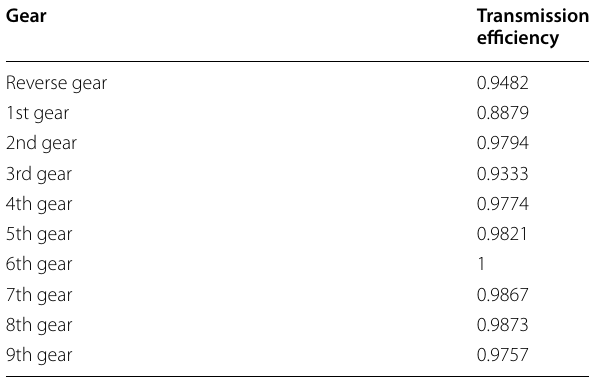
Table 7 Transmission efficiency under each gear